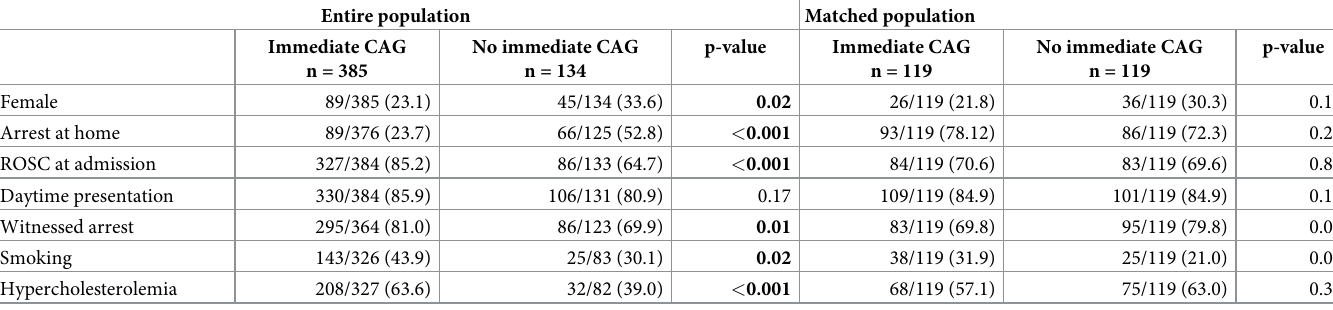
Table 7. Patients with immediate CAG and no immediate CAG according to the matching